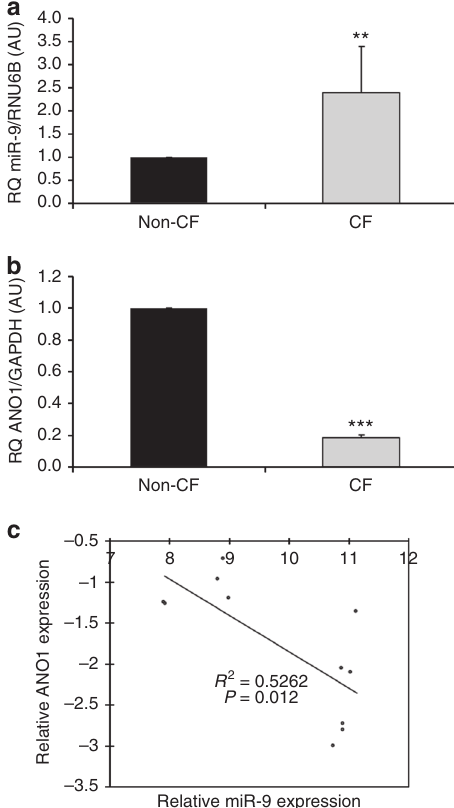
Fig. 1 Correlation of downregulation of ANO1 mRNA and upregulation of miR-9. a miR-9 expression in non-CF (16HBE14o-; n = 5) and CF (CFBE41o-; n = 6) bronchial epithelial cell lines measured by qRT-PCR. Relative expression levels were normalized to those of RNU6B. Data are presented as the mean ± SD and were compared using Student ’ s t -test. All qRT-PCR experiments were performed in triplicate. b Relative expression levels of ANO1 mRNA in non-CF (16HBE14o-; n = 5) and CF (CFBE41o-; n = 6) human bronchial epithelial cells normalized to GAPDH. Data are quanti fi ed by qRT-PCR and are presented as a fold-change compared to normalized controls. Data are presented as the mean ± SD and were compared using Student ’ s t -test. All qRT-PCR experiments were performed in triplicate. c Pearson ’ s correlation analysis showed a negative correlation between miR-9 and ANO1 mRNA expression levels in non-CF and CF bronchial epithelial cell lines ( P =